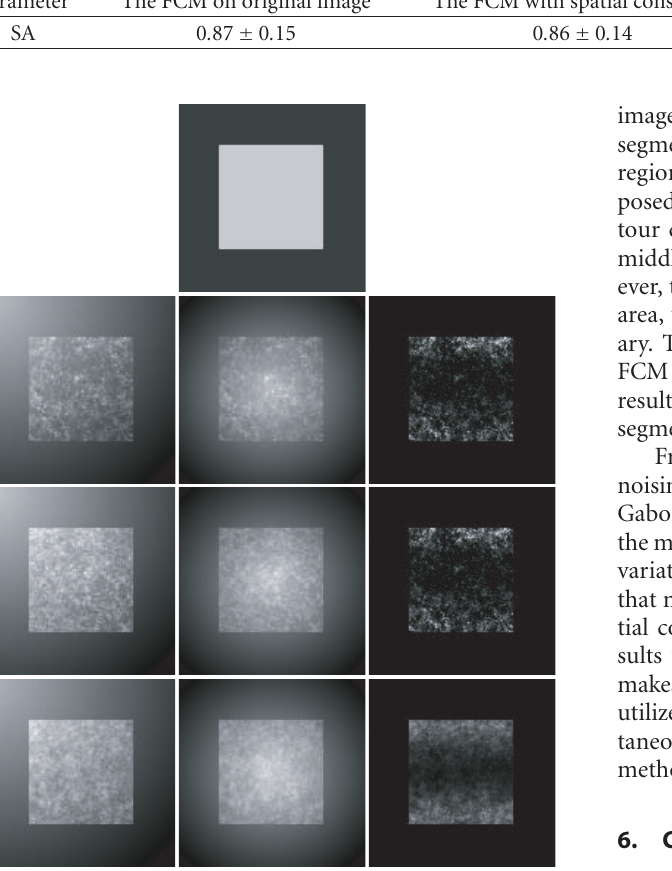
Table 2: SA of the three-conventional FCM and 2DFCM on images with di ff erent imaging conditions. Parameter